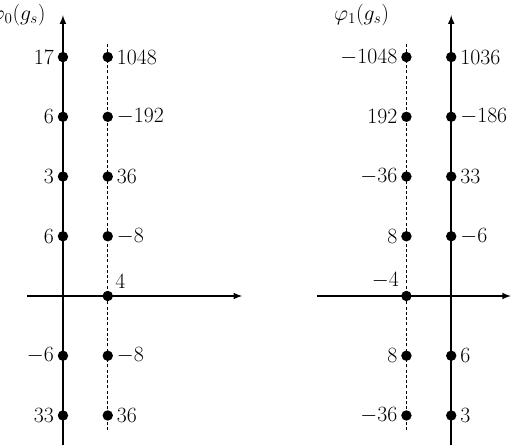
( g ) , Φ ( g ) } of s s 0, n 1, n